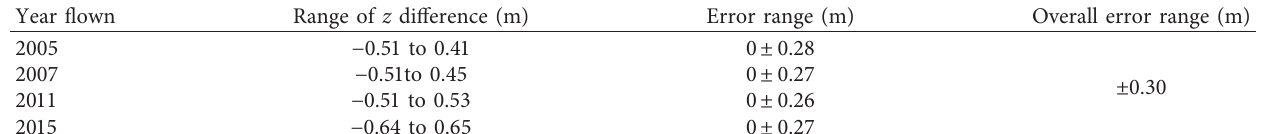
Table 1: z value difference comparison in areas of data